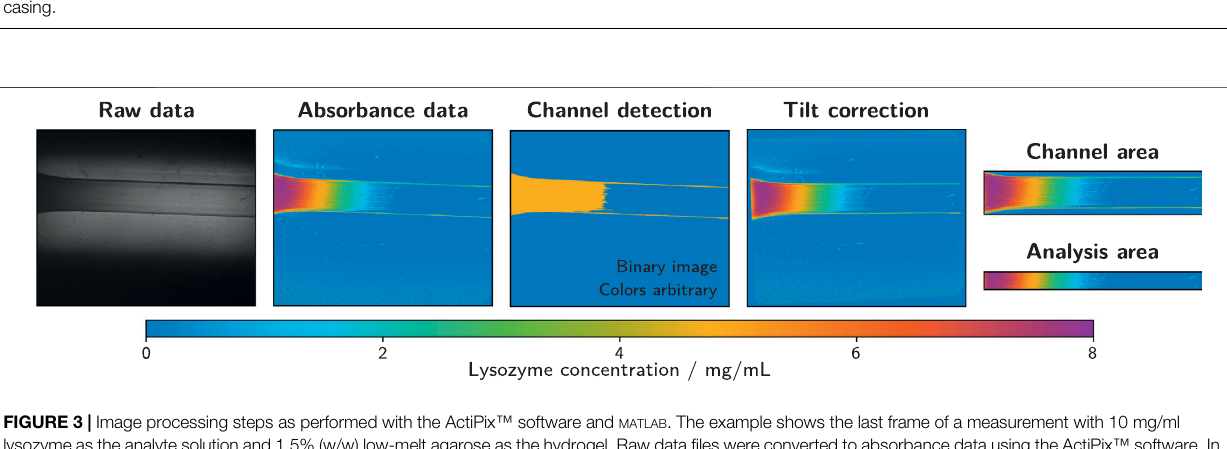
Frontiers in Bioengineering and Biotechnology |